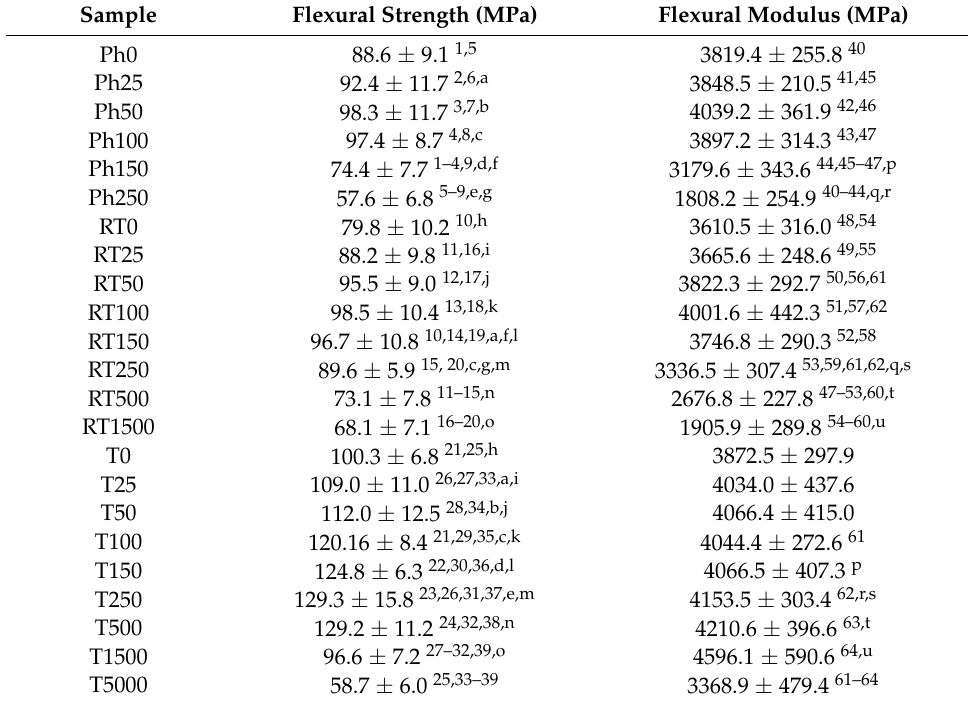
Table 4. The flexural properties of studied Bis-GMA/TEGDMA/AgNP nanocomposites.